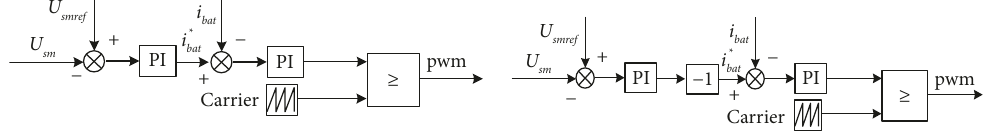
Figure 10: Bidirectional DC-DC control system.